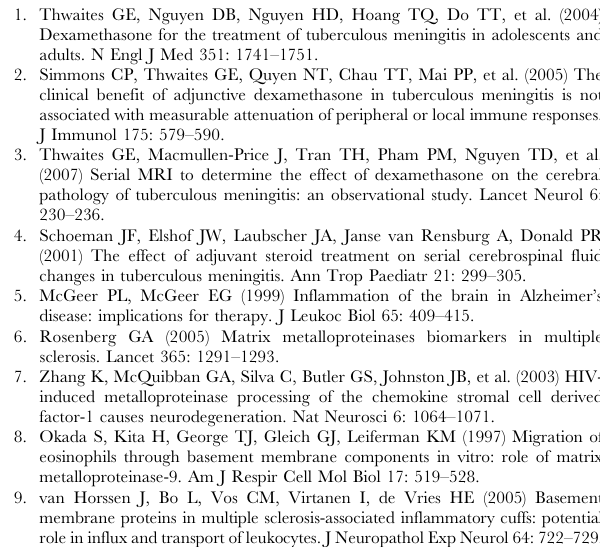
Table S1 Summary of CSF MMP/TIMP concentrations at all time points. # Data for all patients presented, paired analysis presented in